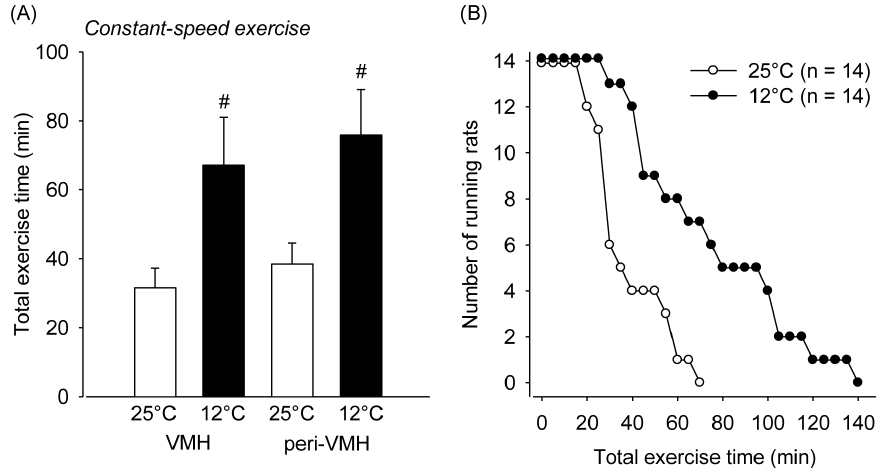
Figure 3. Total exercise time for the animals that were implanted with a guide cannula in the VMH or in the peri-VMH area. Constant- speed running (20 m/min and 5% inclination) was performed at ambient temperatures of 25 u C and 12 u C (panel A). # P , 0.05 compared with the experimental trials at 25 u C. The curves presented in the panel B show the maximum exercise duration tolerated by the rats subjected to the constant exercise sessions (panel B). The data are expressed as the number of rats that continued to run at specific time points at each ambient temperature.